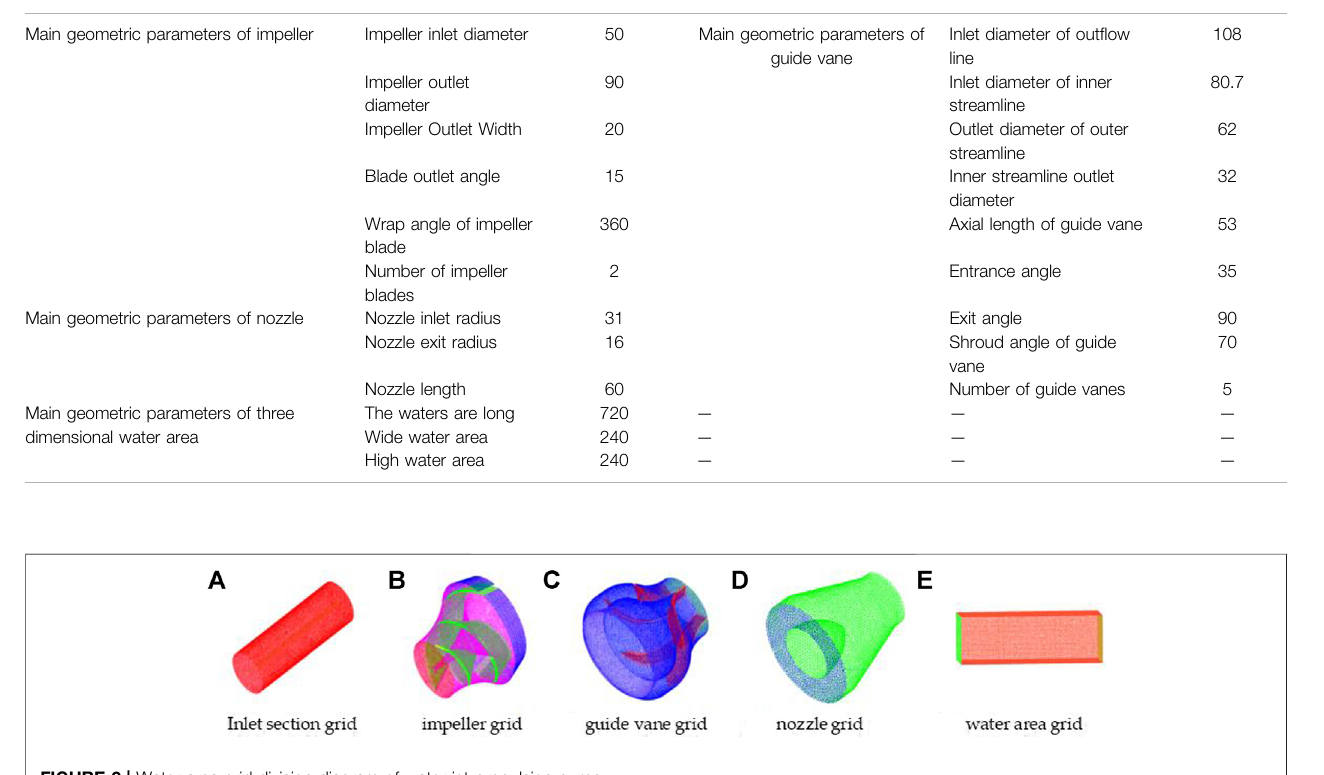
FIGURE 2 | Water area grid division diagram of water jet propulsion pump.